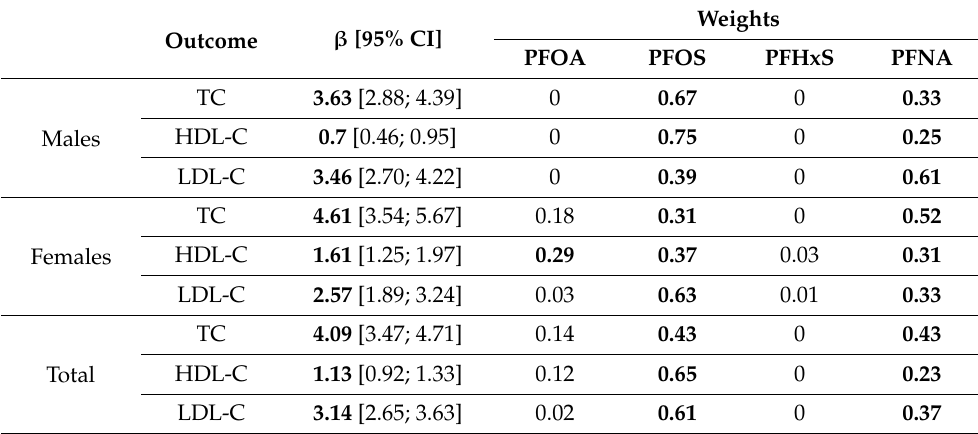
Table 2. Associations between WQS regression index and serum lipids (mg/dL). WQS estimates * and 95% confidence intervals for the change in TC, HDL-C and LDL-C, stratified by gender. WQS regression model weights of each PFAS component, for each